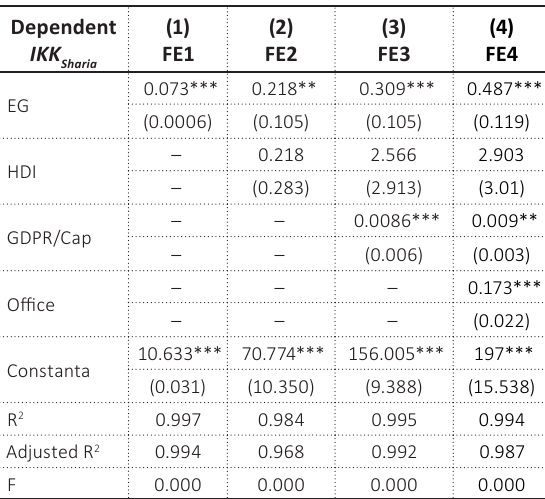
Table 7. Effect of EG, HDI, GDPR/Cap and Office on IKK